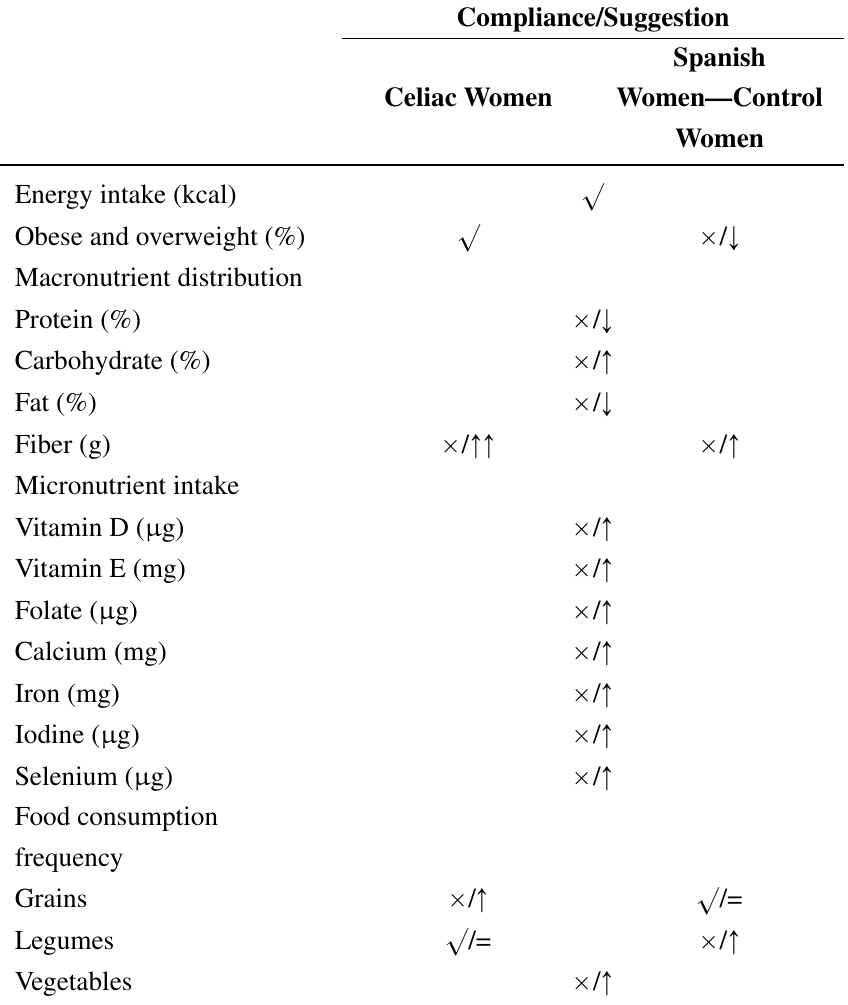
Table 4. Summary of Spanish societies recommendations’ compliance concerning energy intake, obese and overweight percentage, nutrients, fiber and food consumption frequency by celiac women and Spanish